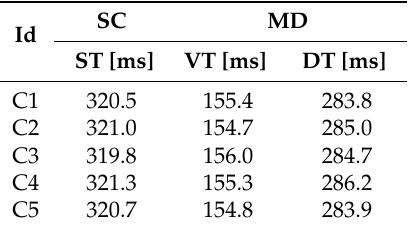
Table 3. Computational time for individual-signcryption. Legend: SC: smart camera, MD: monitoring